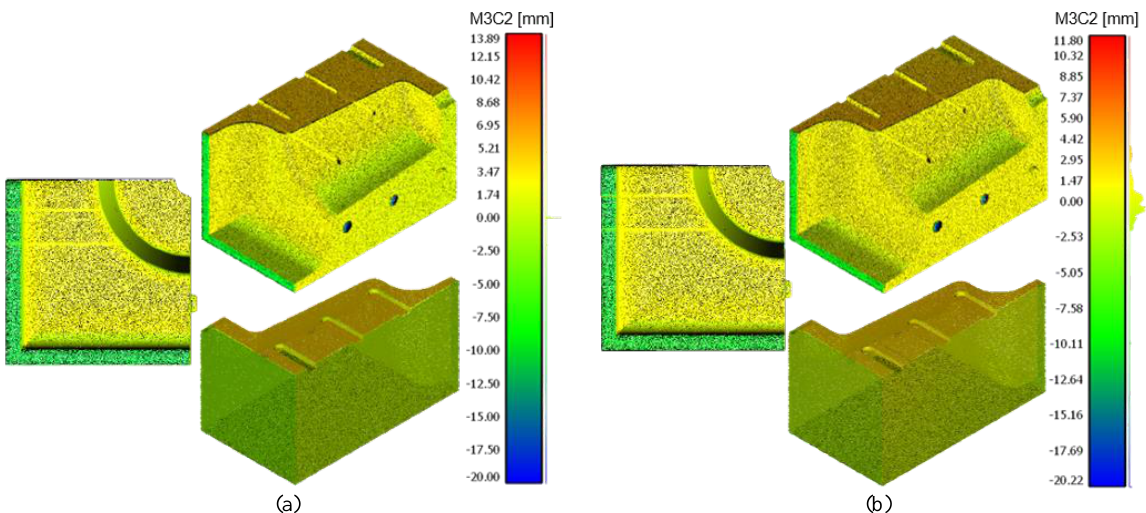
Figure 6. Deviation distance analysis of the simulated data using M3C2. (a): GT-Pose, and (b): ICP.